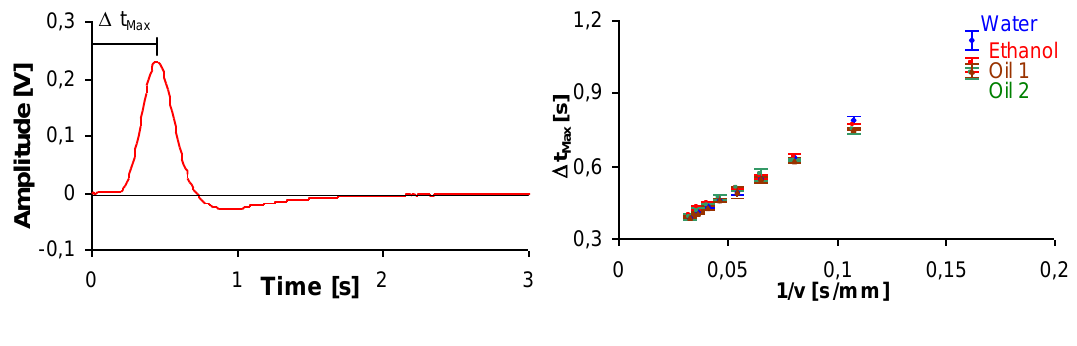
∆t for different fluids as a function of the inverse of the mean flow velocity ( right Max